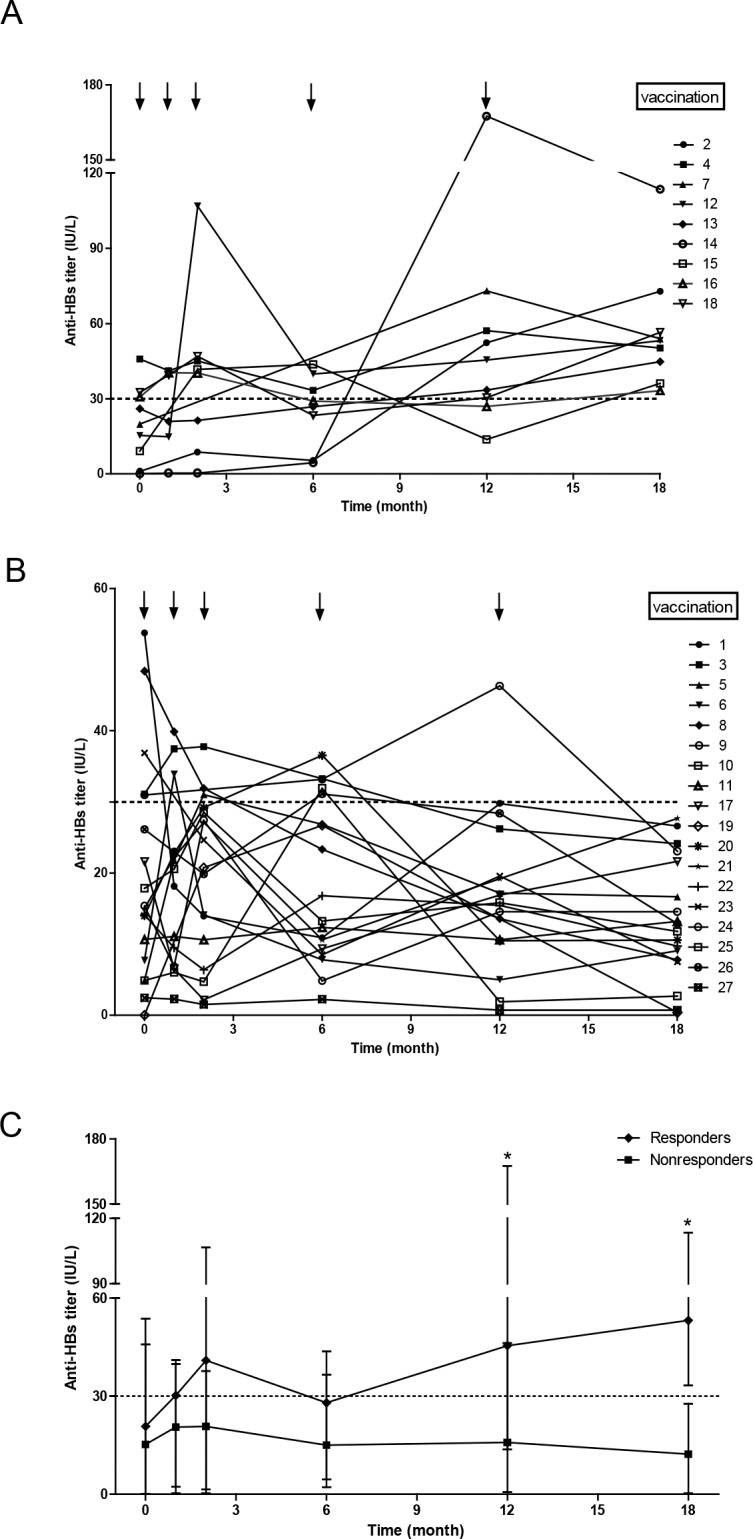
The dynamic changes of anti-HBs titers during the vaccination and follow-up periods.(A) Responders, (B) non-responders and (C) overall kinetics of both groups. *Mann–Whitney U-tests, P<0.01.